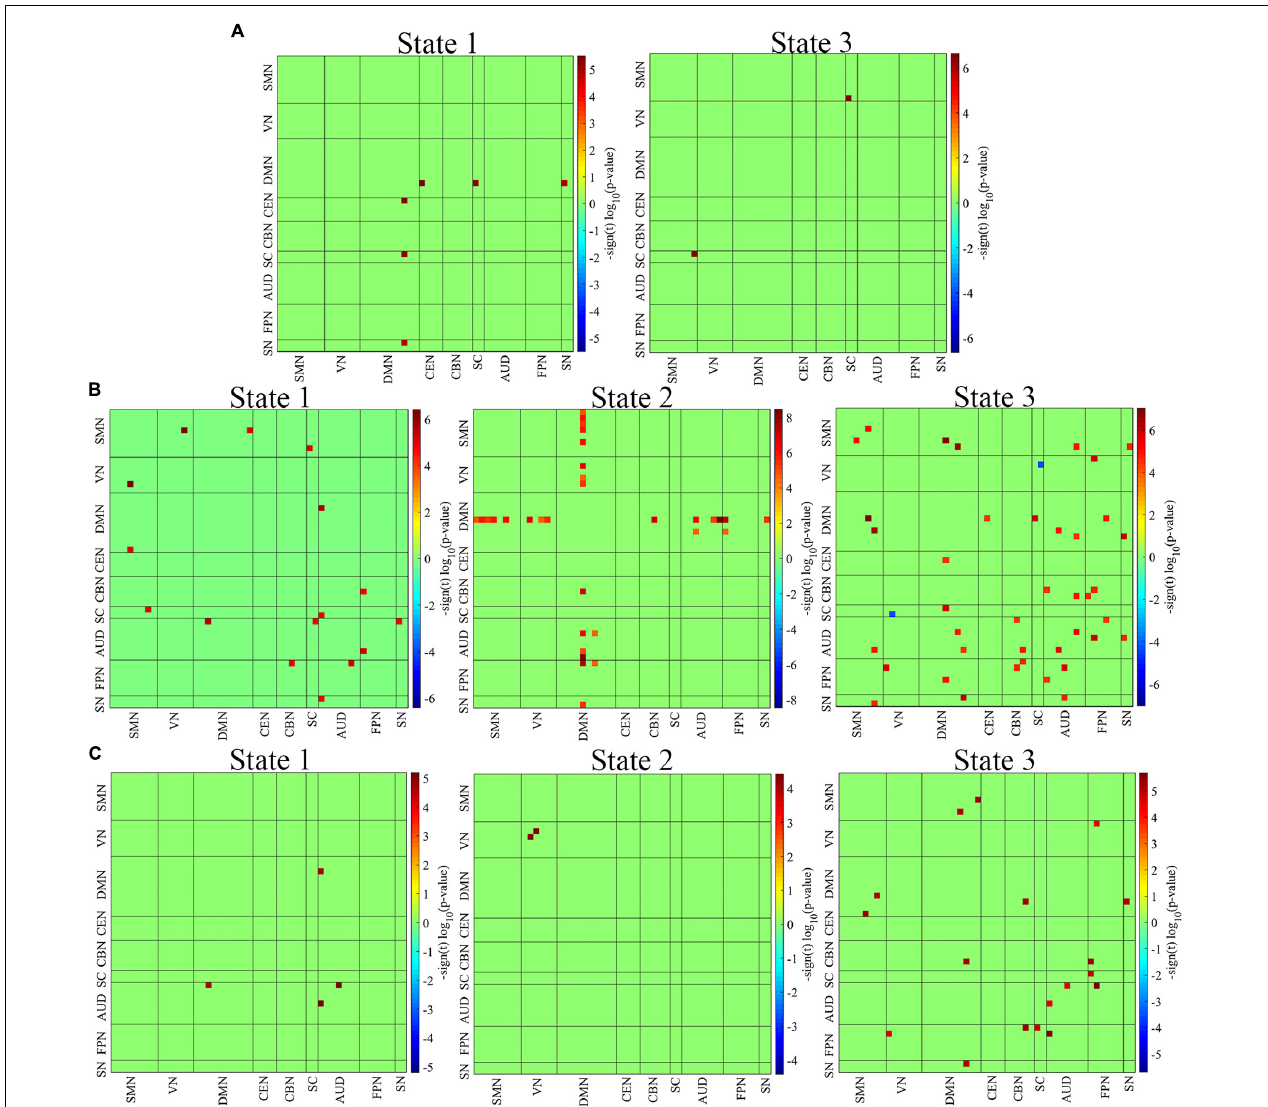
FIGURE 3 | Group differences among the three age groups. (A) Adolescent vs. Child ADHD patients. (B) Adult vs. Child ADHD patients. (C) Adult vs. Adolescent ADHD patients. Two out of the three clusters showed significant differences between child and adolescent ADHD patients, whiles all three clusters showed significant differences between child/adolescent and adult ADHD patients ( P < 0.01, FDR corrected). The red squares indicate increased network connectivity whiles the blue squares indicate decreased network